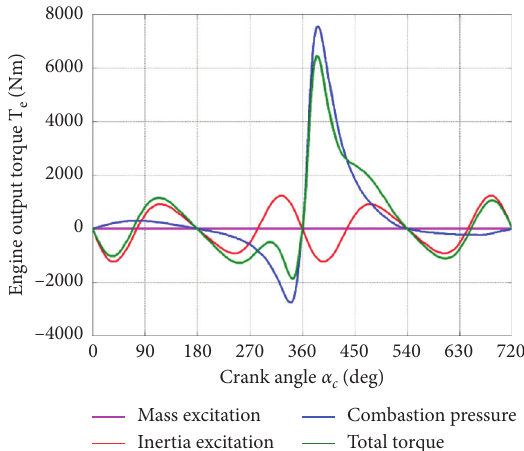
Figure 5: The torsional torque of the single cylinder.